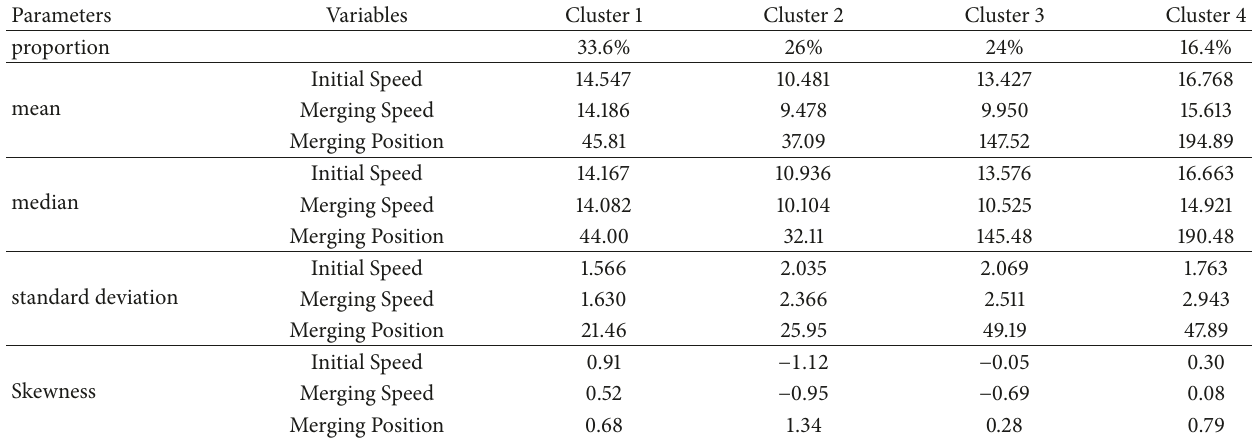
Table 1: Results of cluster